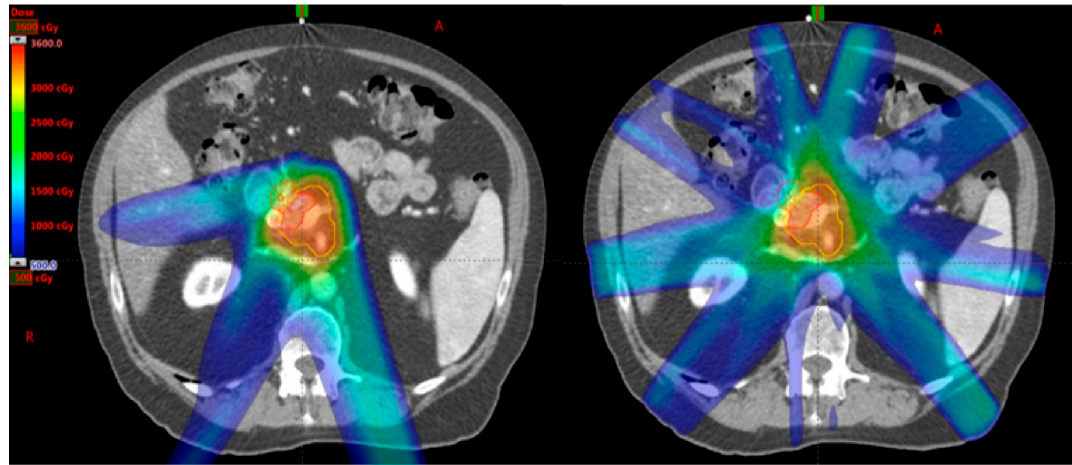
Figure 2. An example of proton ( Left ) and photon ( Right ) SBRT plans on the same patient. Note that there is less low dose scatter in the proton plan due to the inherent physical properties of proton particles compared to photon.